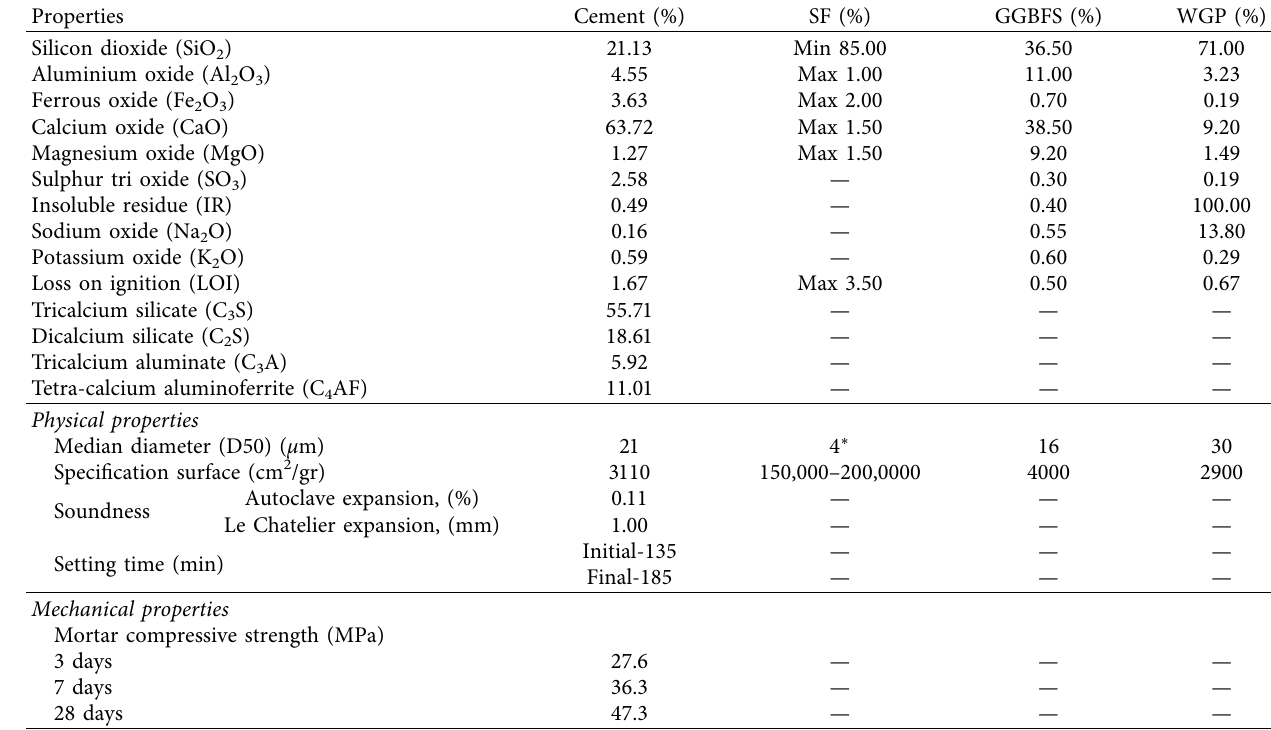
Table 1: Chemical, physical, and mechanical properties of cement, SF, GGBFS, and WGP.